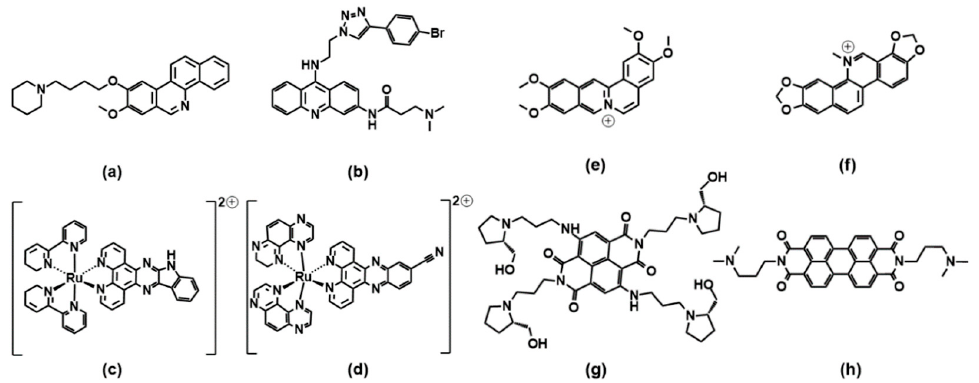
Figure 10. Molecular structures of the G4-topology switchers reviewed here; ( a ) [95], ( b ) [9], ( c ) [96], ( d ) [98],( e ) [99], ( f ) [100], ( g ) [101], ( h )